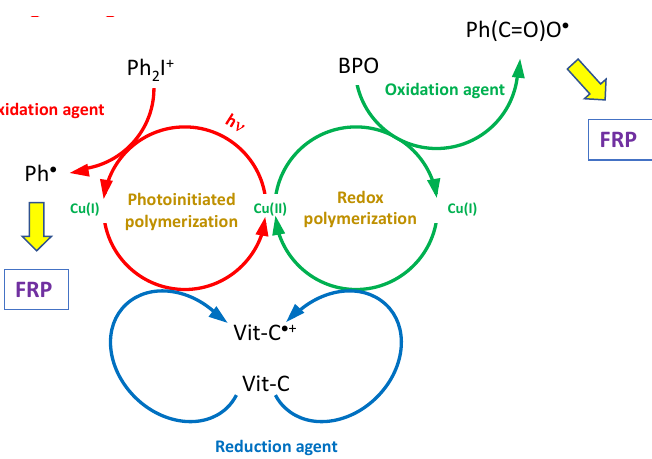
Figure 34. The two concomitant mechanisms involved in the photo (redox) polymerization with the four-component (Cu(Oct) 2 / Vit-C / BPO / Iod) system upon photoexcitation of the curable resin.